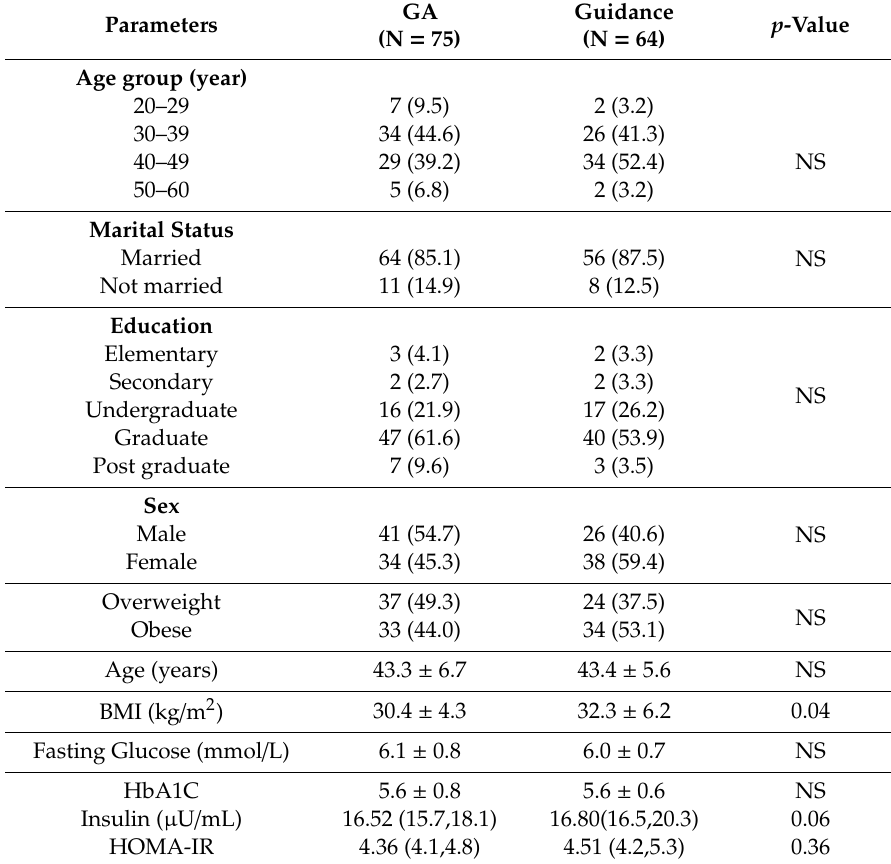
Table 1. General, anthropometric, and biochemical characteristics of study groups at